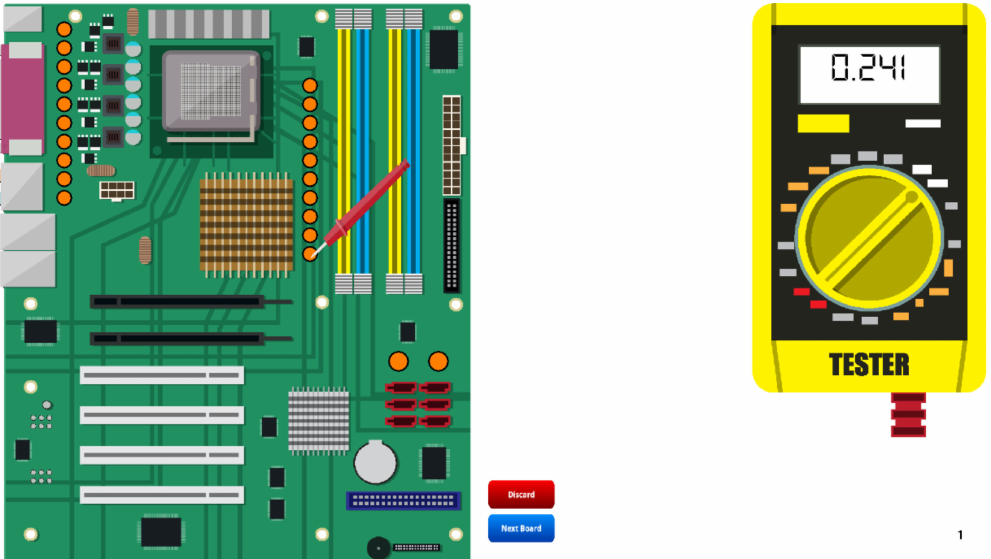
Figure A2. This figure depicts the software-generated printed circuit board ( left panel ) and multimeter ( right panel ) used in our simulated assembly line task. Using the movable red probe (shown on the circuit board), participants were required to test the values of resistances, by placing the tool on the orange circles. The values of the resistance were displayed on the multimeter. Based on the values of the resistances, participants have several options, as described in the text. The software is freely available after contacting the corresponding